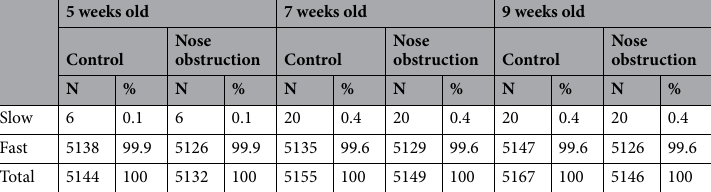
Table 2. Number of slow and fast muscle fibers and percentage in genioglossus muscle. Data presented as total number (N), and percentage (%). Slow slow type muscle fiber, Fast fast type muscle fiber.